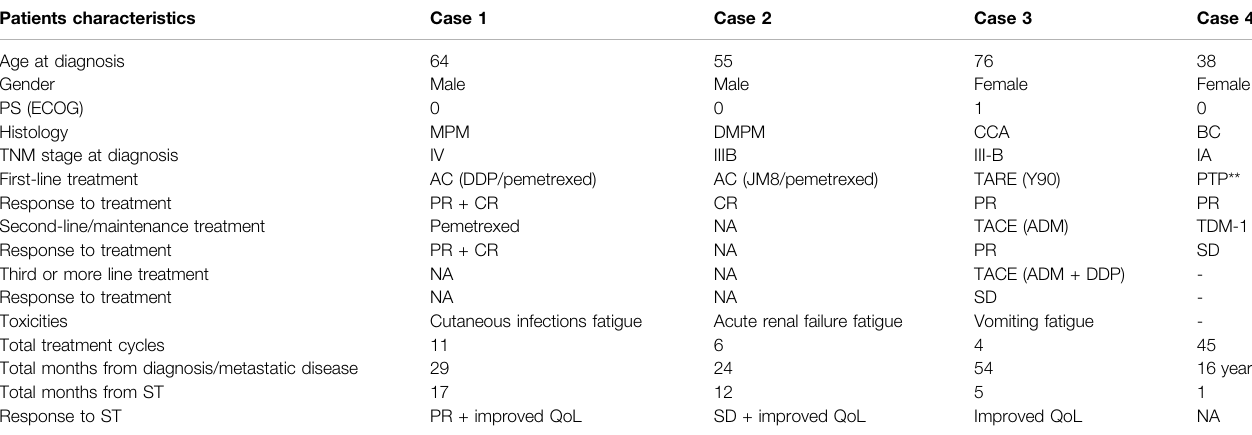
TABLE 1 | Patients ’ clinical characteristics. Patients characteristics